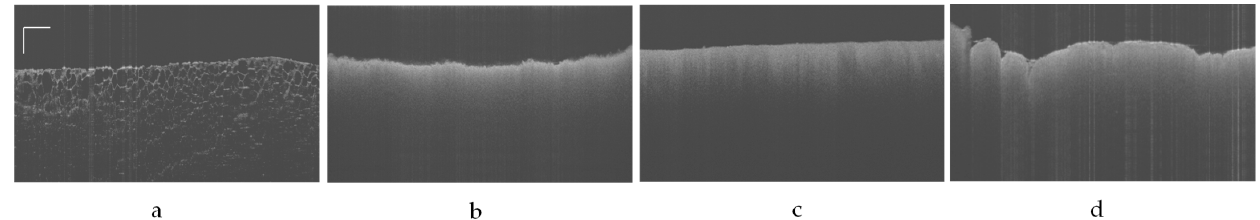
Figure 3. Representative sd-OCT B-scan images of ( a ) lipoma, ( b ) mast cell tumor, ( c ) soft tissue sarcoma, and ( d ) skin. Scale bar: 500 μ m.